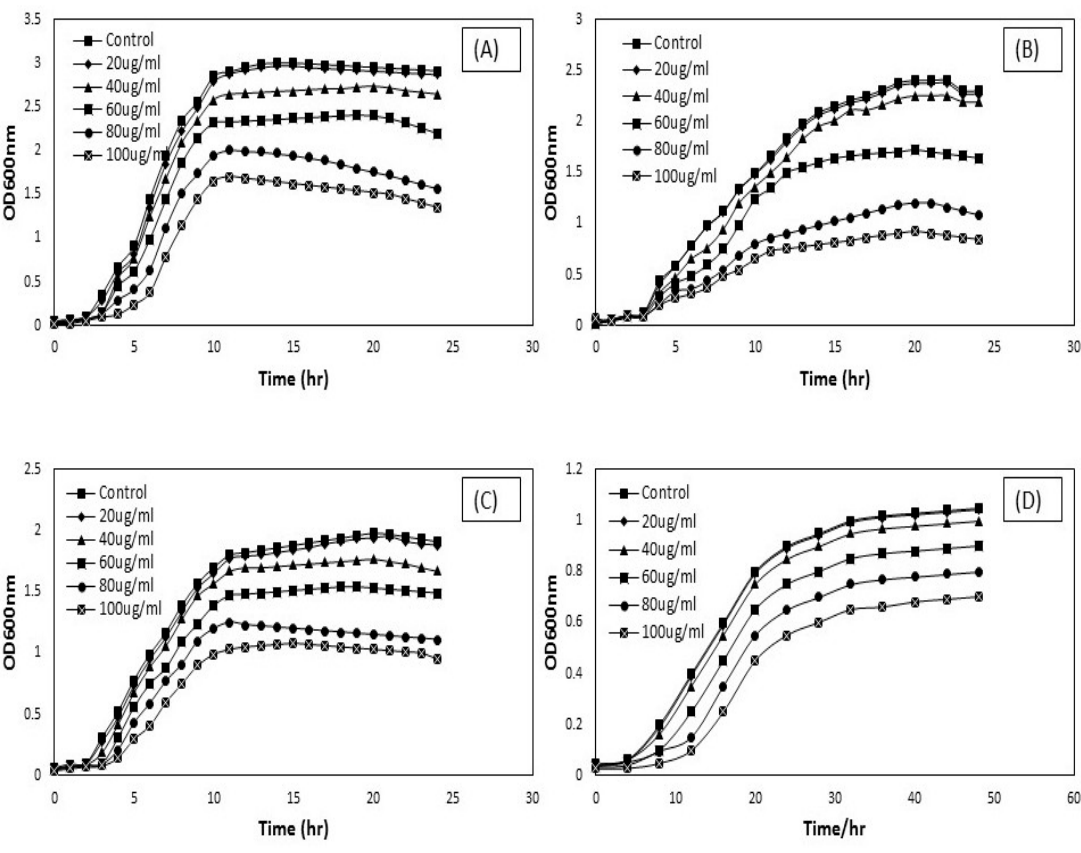
Figure 7. OD growth curves attained when 150 µ L of ~10 7 –10 8 CFU / mL Staphylococcus aureus ( A ), Pseudomonas aeruginosa ( B ), Klebsiella pneumoniae ( C ), and Candida albican ( D ) was treated with